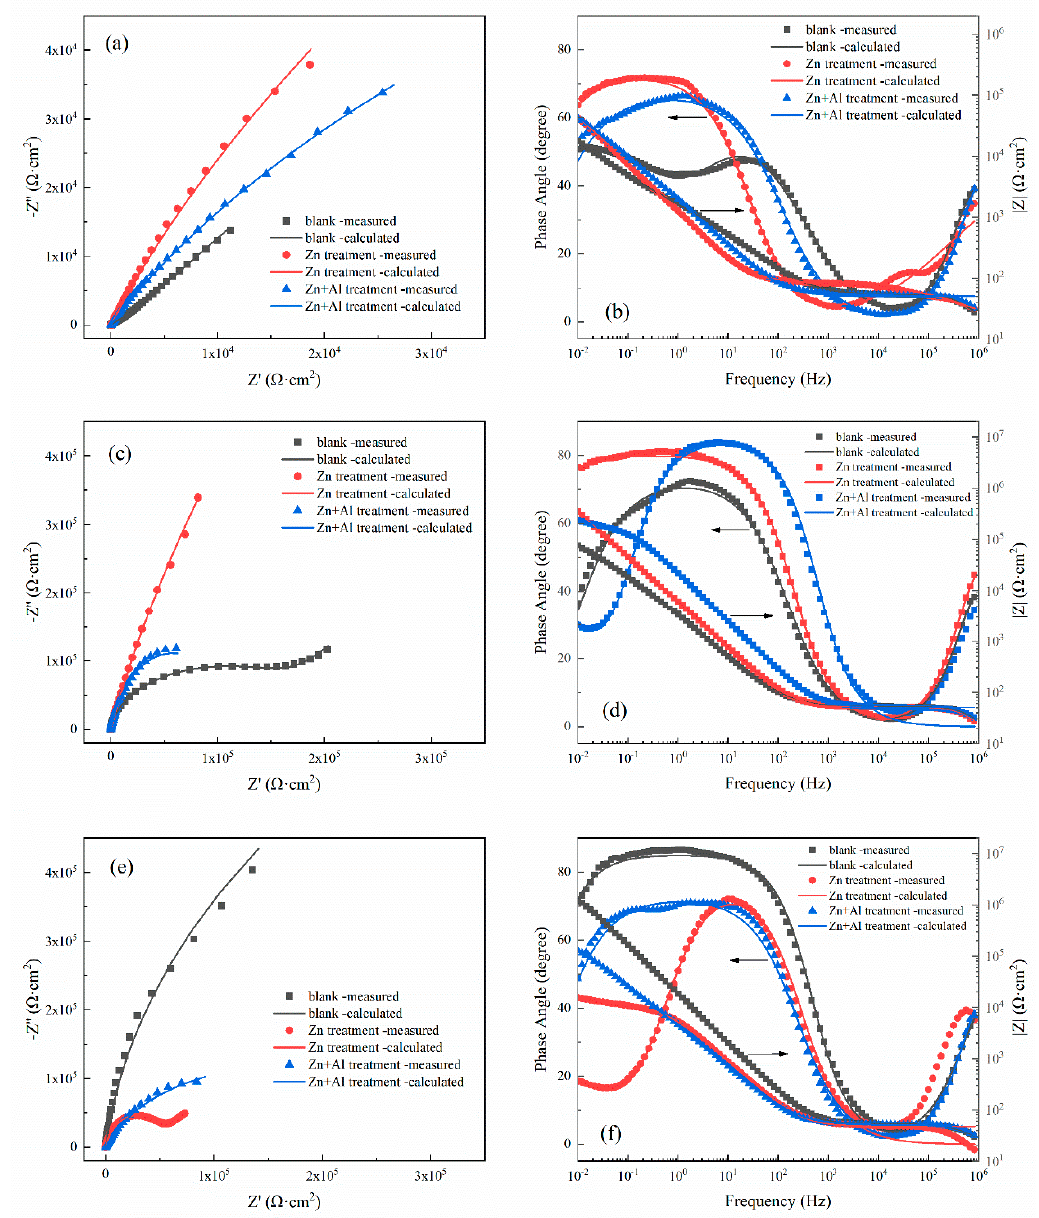
Figure 2. The EIS of the passive films formed on different materials with different treatment methods: ( a ) A508-3, Nyquist diagram; ( b ) A508-3, Bode diagram; ( c ) 304L, Nyquist diagram; ( d ) 304L, Bode diagram; ( e ) In800, Nyquist diagram; ( f ) In800, Bode diagram.